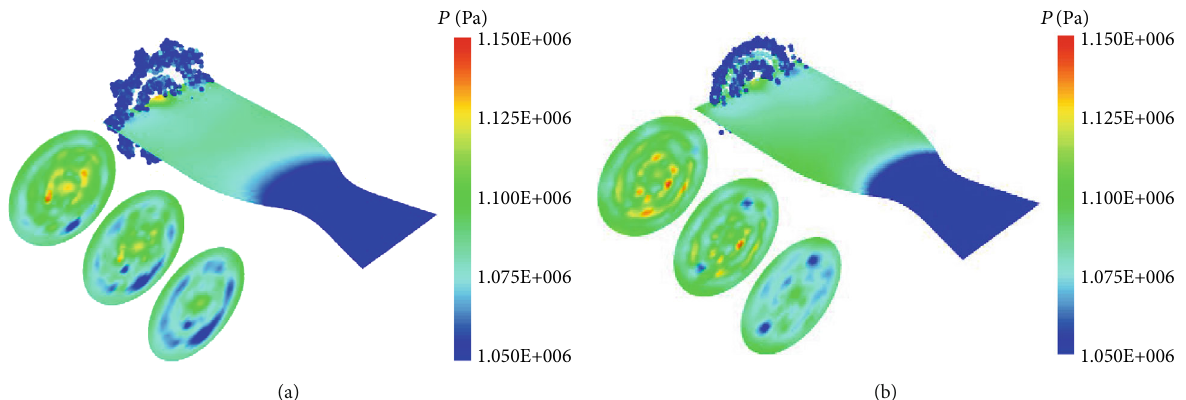
Figure 13: The acoustic pressure contours in Case 1. (a) 8.26919ms, MMH. (b) 9.43105ms, NTO.